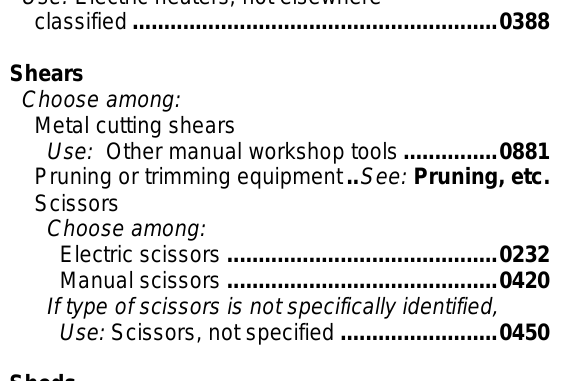
Shakers, salt or pepper Use: Tableware and accessories